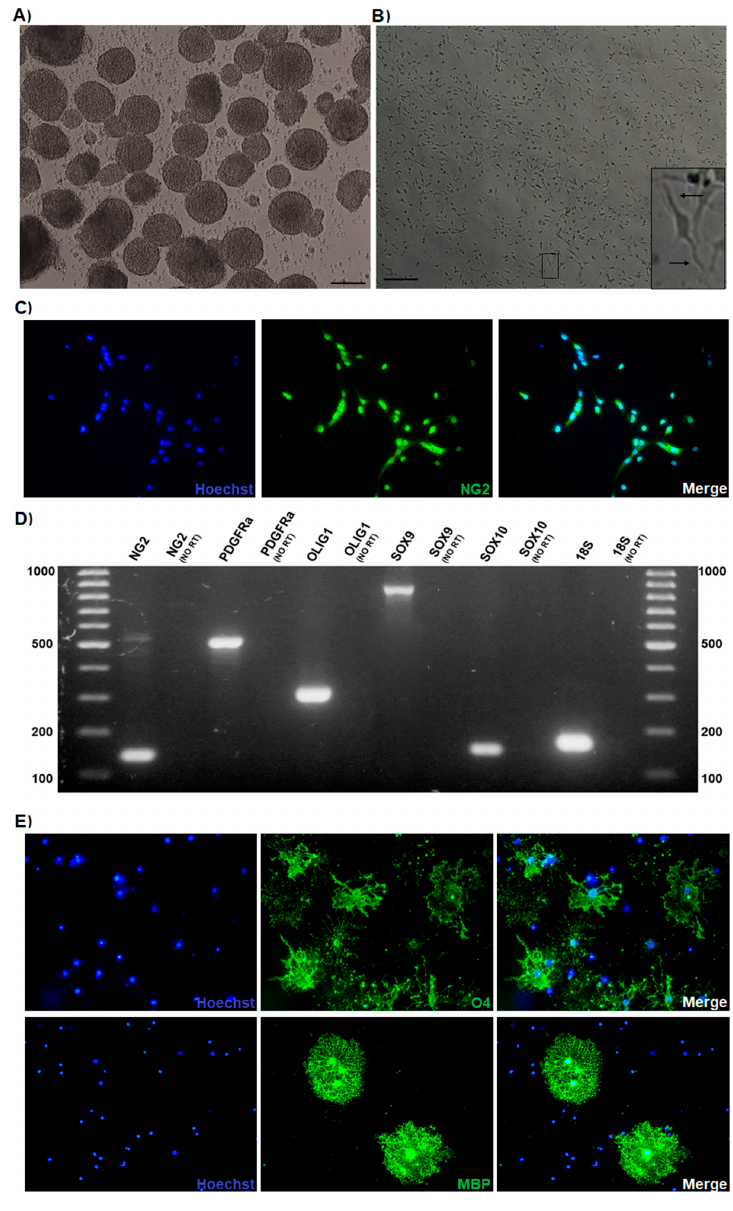
Figure 1. Oligodendroglial progenitor cells (OPC) cultures derived from the spinal cord of E14.5 mouse embryos. ( A ) Primary neurosphere cultures generated from the mouse embryonic spinal cord. ( B ) Selective OPC expansion from the neurospheres. The arrows in the zoomed area shows the bipolar processes. Scale bars: 100 µ m. ( C ) Immunodetection of the typical OPC marker NG2 in the cultured cells. Nuclei stained with Hoechst are shown in blue, anti-NG2 primary antibody is shown in green, and merge panel shows the combination of blue and green colors. ( D ) The expression of the oligodendrogial genes NG2 (143 bp), PDGFRa (524 bp), OLIG1 (309 bp), SOX9 (820 bp), and SOX10 (146 bp) was detected in the cultured cells by RT-PCR. ( E ) The OPC were cultured without growth factors and treated for 3 days with T3 hormone (40 ng / mL); di ff erentiation was evaluated by immunodetection of the oligodendrocyte marker O4 and the myelin marker myelin basic protein (MBP). All immunofluorescence images were captured with 400 ×